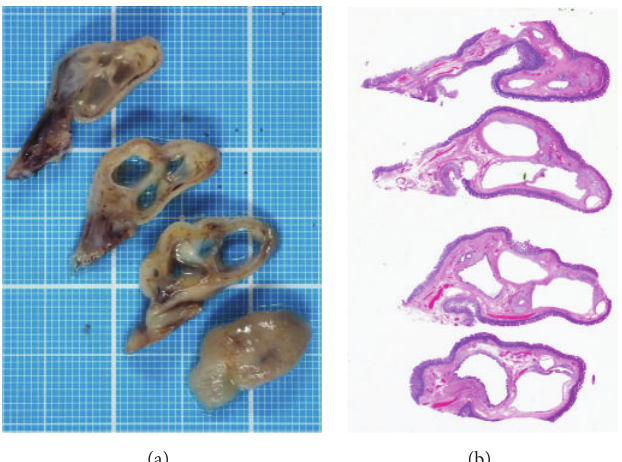
Figure 4: Images of the resected specimen. Macroscopically, multiple cystic structures can be observed in the head of the polyp, whereas no cyst is visible in the